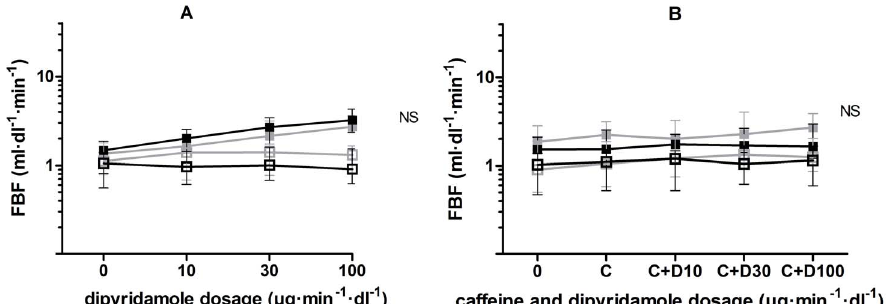
Figure 3. FBF response to dipyridamole, without and with caffeine. FBF response to A dipyridamole and B dipyridamole (D) in incremental dosages during concomitant administration of caffeine (C) in a constant dosage of 90 m g ? dL 2 1 ? min 2 1 , during placebo (grey) and eplerenone (black) treatment in the experimental (filled squares) and non-experimental (open squares) arm. doi:10.1371/journal.pone.0111248.g003 PLOS ONE |